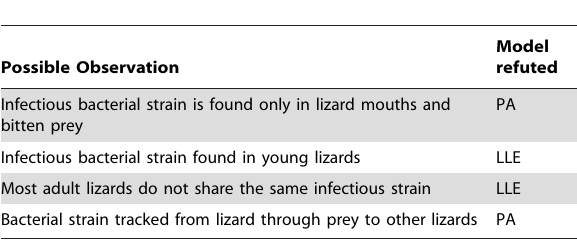
Table 1. Further tests to refute the lizard-lizard epidemic model (LLE) and passive acquisition (PA)